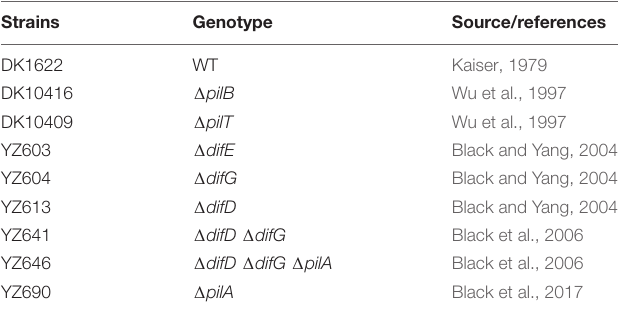
TABLE 1 | Myxococcus xanthus strains used in this